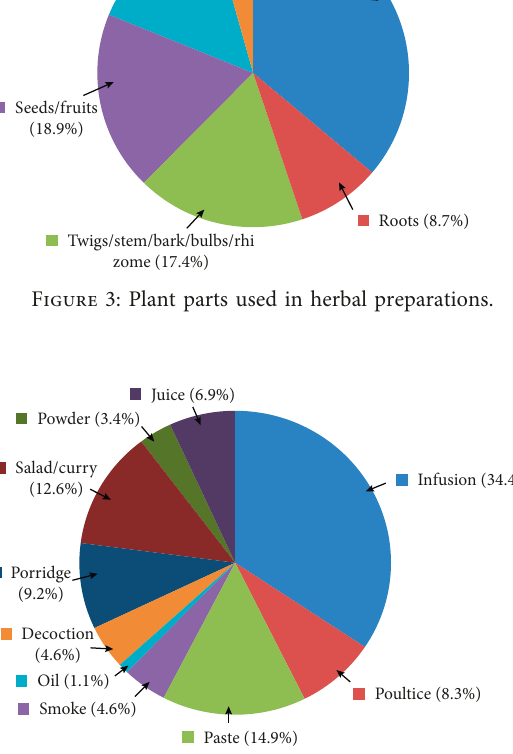
Figure 4: Mode of utilization of plants to treat various disease conditions.